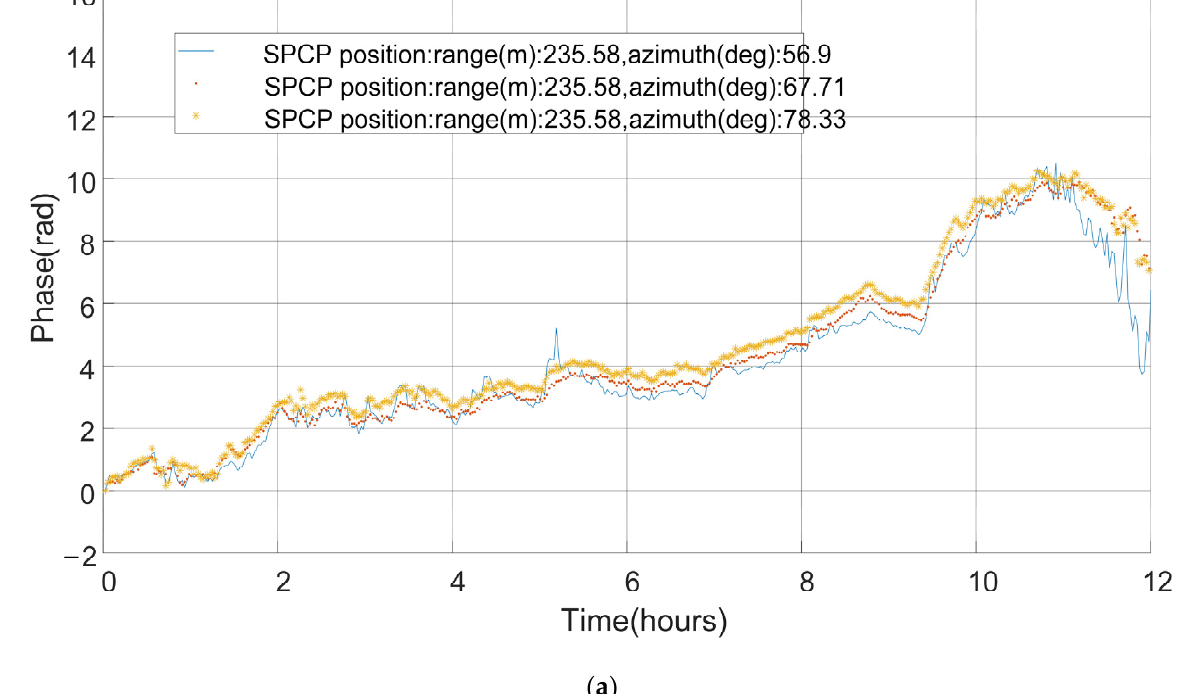
11 of 19 Figure 9. The screening results of SPCPs.